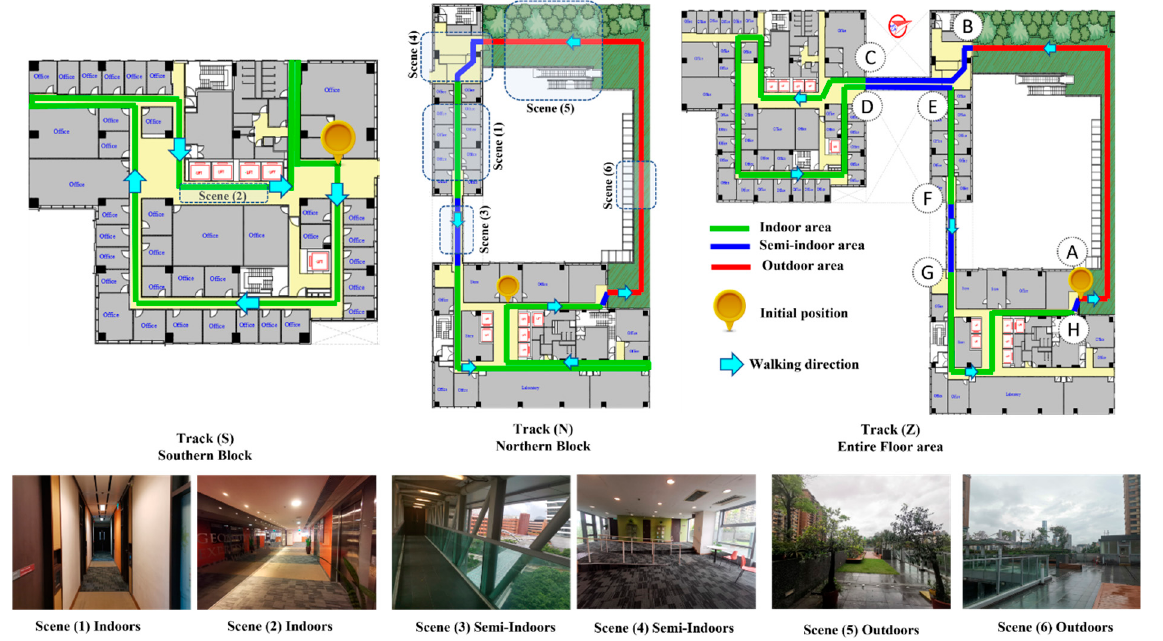
Figure 8. Test areas. In Track (Z), the letters (A–H) refer to the start of the transitions from indoors to outdoors or vice versa used to evaluate the detection latency in Figure 10.